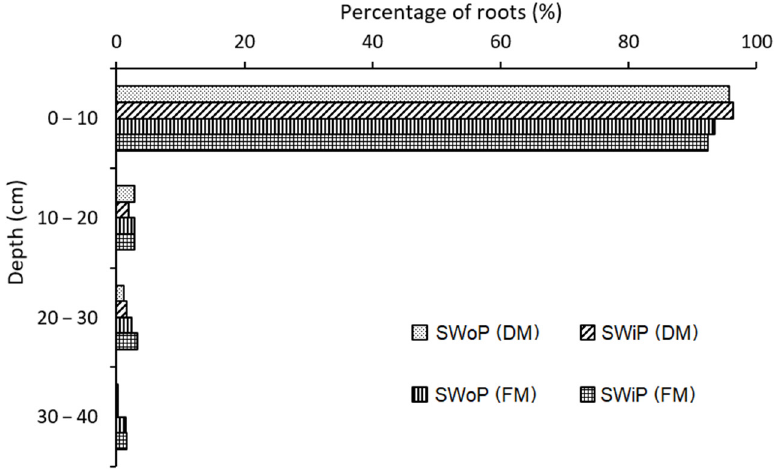
Figure 7. Percentage distribution of the root system along the soil profile for strawberry cultivated without recycled paper mulch (SWoP) and with recycled paper mulch (SWiP), for the fresh (FM) and dry (DM) mass of roots.